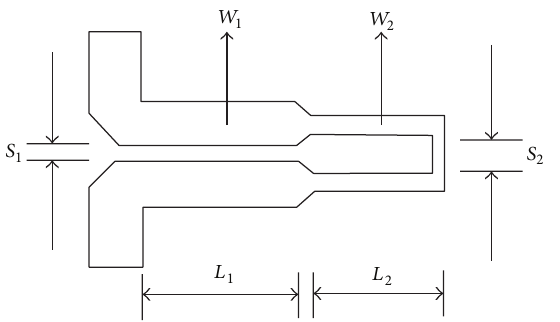
Figure 5: The structure of the Schiffman differential phase shifter.